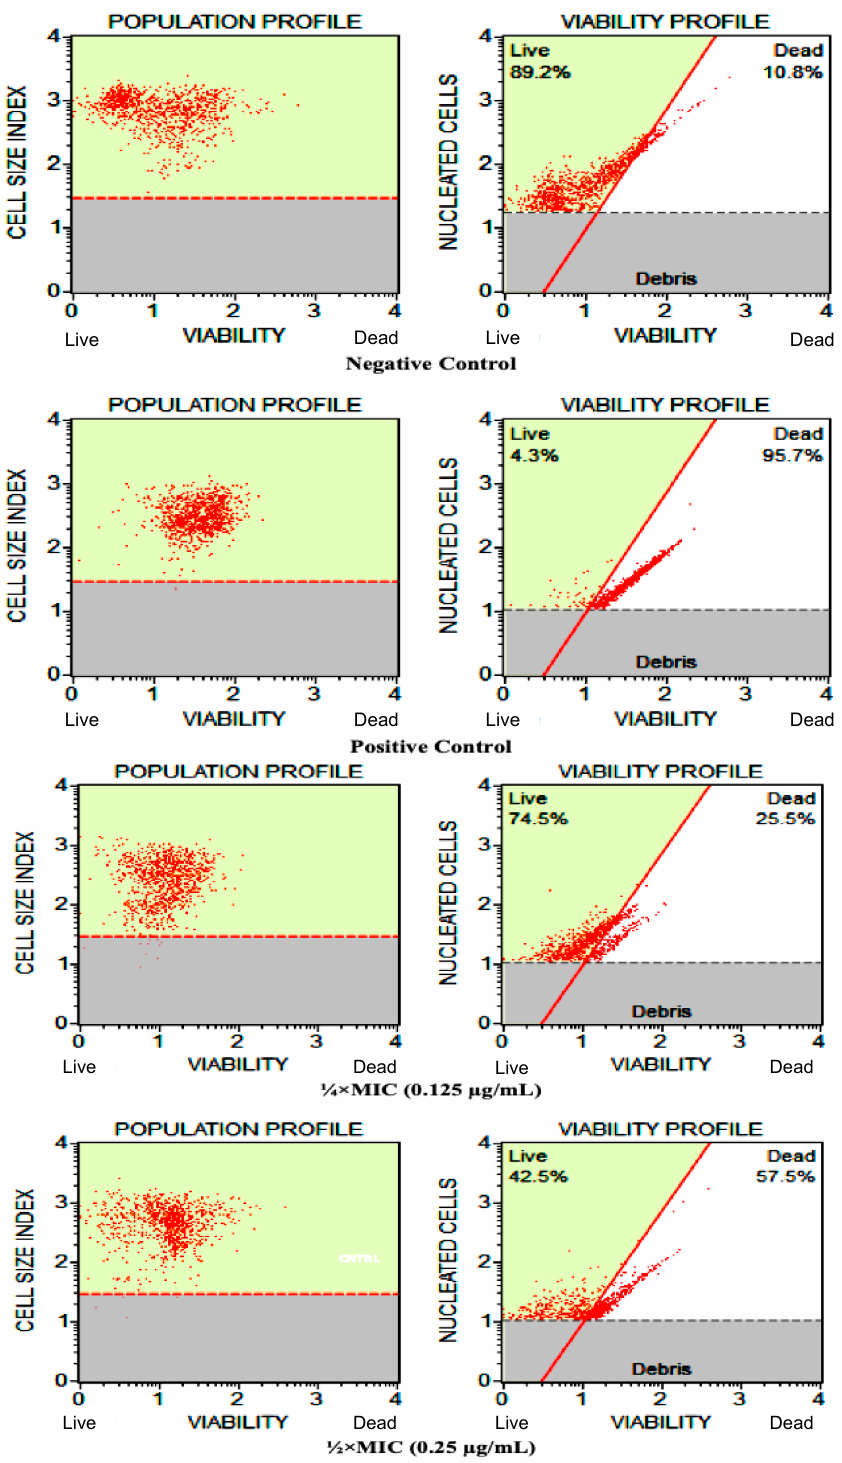
Figure 9. Effect of Ag-Cu bimetallic NPs on cell count and viability of C. albicans SC5314. Figure demonstrates viability and population profile of C. albicans . Healthy growing C. albicans represented as negative control; heat-killed cells as positive control; C. albicans exposed to Ag-Cu bimetallic NPs at different MIC values (¼ × MIC and ½ × MIC).